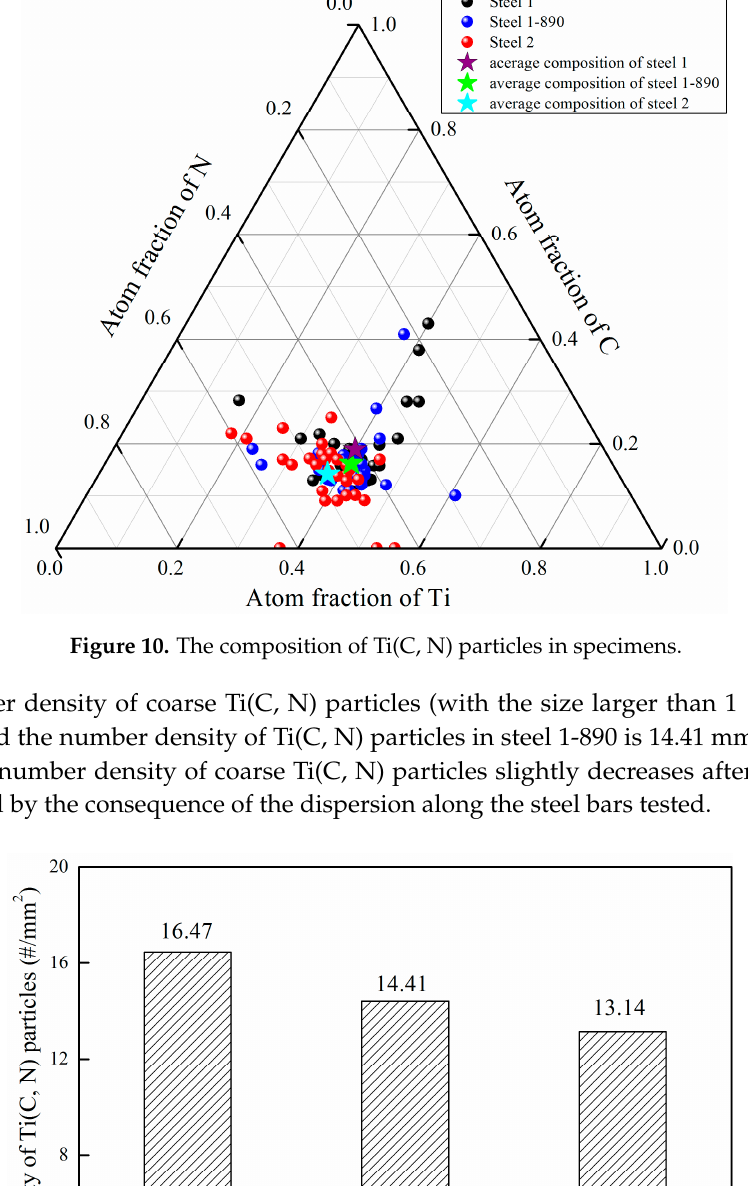
Figure 9. Coarse Ti(C, N) particles located in ferrite ( a ) and pearlite ( b – d ) in steel 2.